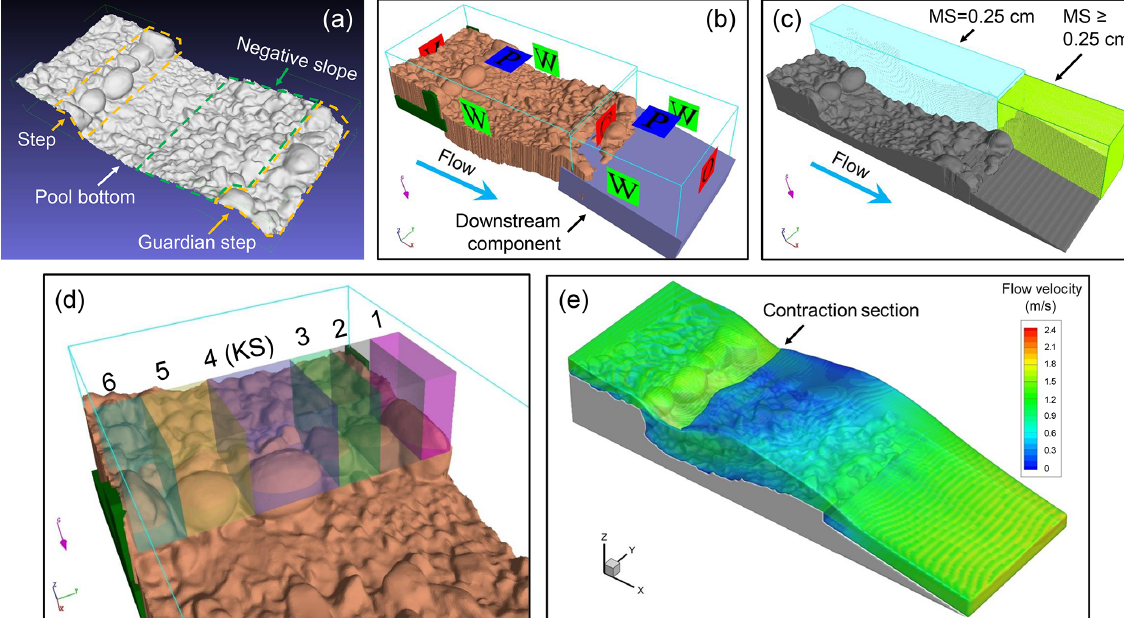
Figure 3. Setup of the CFD model. (a) Three-dimensional digital surface model (DSM) of the step-pool unit by the SfM-MVS method as the input to the 3D CFD modeling. (b) Extruded bed surface model connected to the extra downstream component (in purple blue) and rectangular columns to fill leaks (in green), with the boundary conditions shown on mesh planes. (c) Recognized geometry in FLOW-3D with two mesh blocks (the upstream block had uniform mesh size, while the downstream one had nonuniform mesh size); MS is short for mesh size. (d) Sampling volumes to capture the flow forces acting on each step stone at X , Y , and Z directions. (e) An example for the simulated 3D flow over the step-pool unit colored by velocity magnitude at the discharge of 49.9Ls − 1 . The abbreviations for boundary conditions in (b) are V for specified velocity, C for continuative, P for specific pressure, and W for wall condition. The contraction section in (e) refers to the cross-section where the jump component starts in the